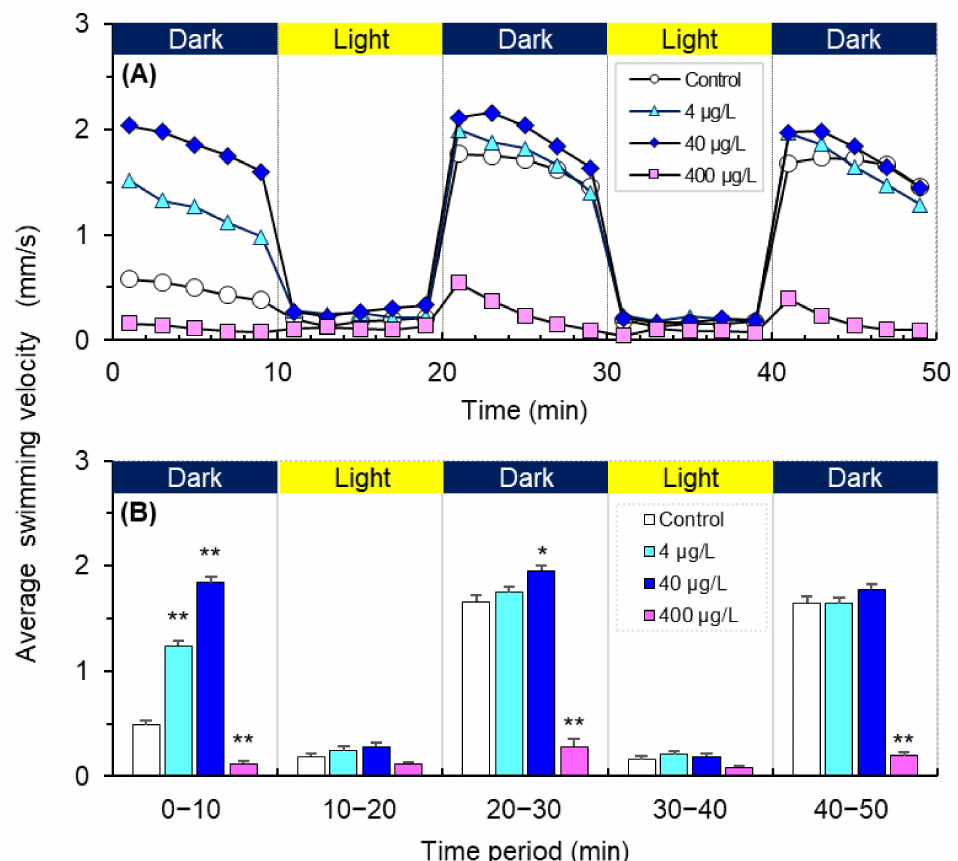
Figure 3. The average swimming velocity of zebrafish ( Danio rerio ) larvae exposed to cetylpyridinium chloride at levels of 0 (control), 4.0, 40, and 400 µ g/L for 120 h post-fertilization. The blue and yellow bars at the top indicate the dark and illumination conditions, respectively. ( A ) Data are presented as the mean value in each 2 min interval. ( B ) Data are presented as means ± SE ( n = 60) within each 10 min period, and asterisks denote statistically significant differences between the exposure and control groups (* p < 0.05; ** p <